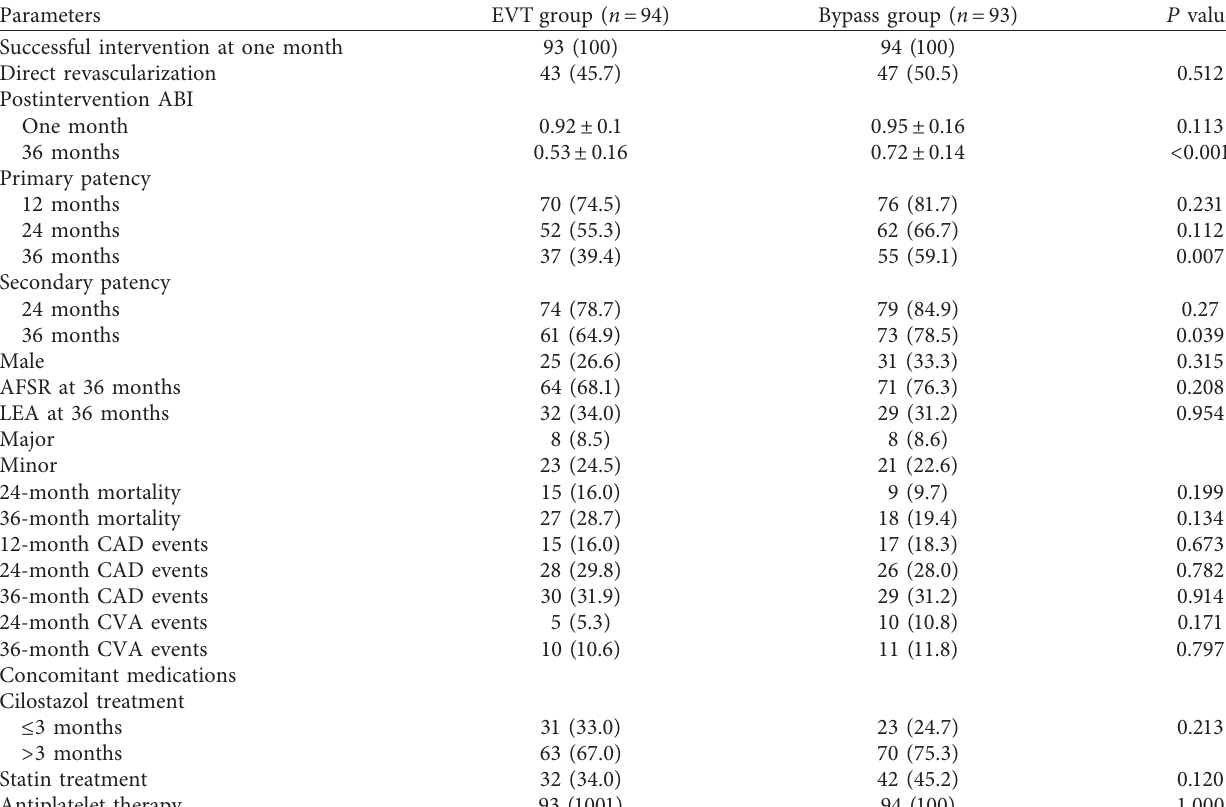
Table 3: Study endpoints associated with treatment methods.